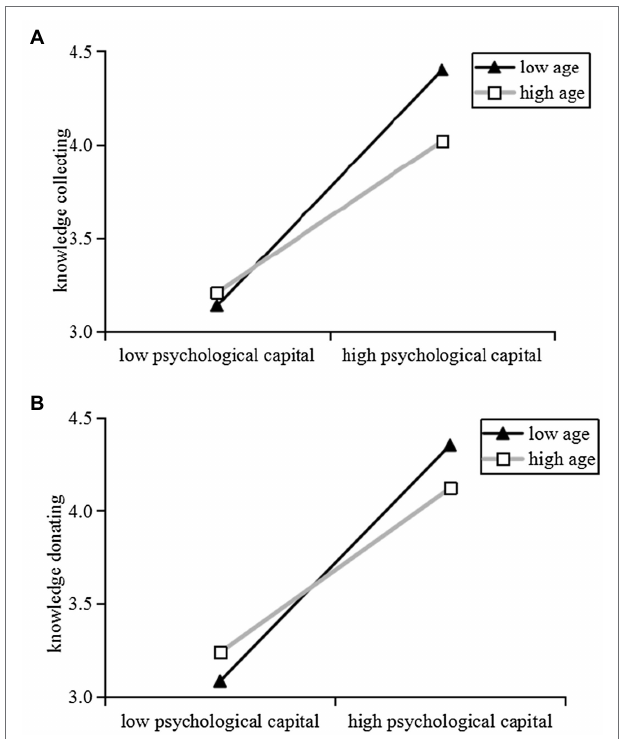
FIGURE 2 | Moderating effect of age. (A) Moderating effect of age on the relationship between psychological capital and knowledge collecting. (B) Moderating effect of age on the relationship between psychological capital and knowledge